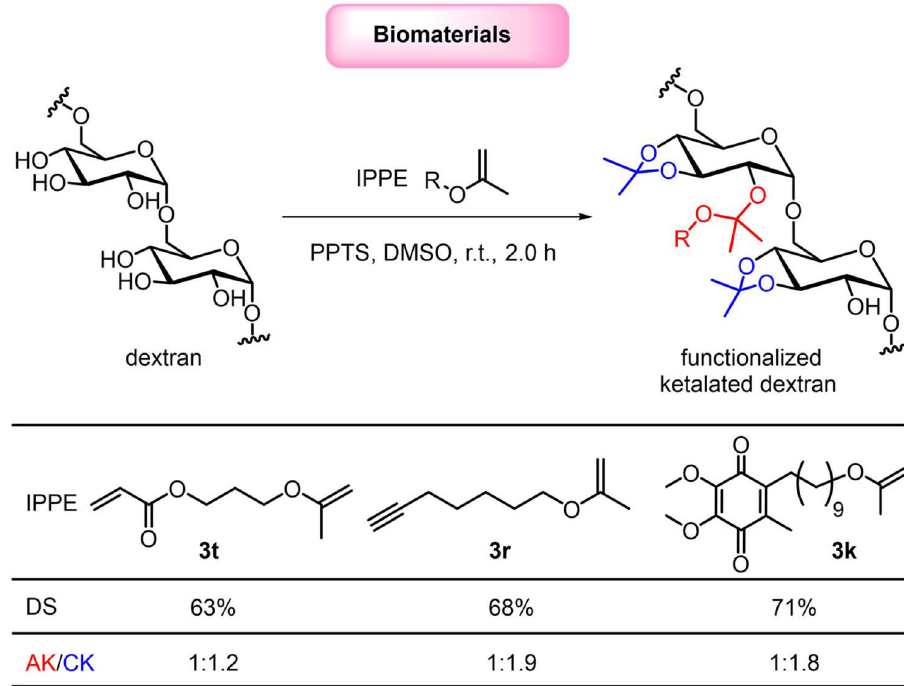
Fig. 6 Ketal-linked biomaterials. Synthesis of functionalized ketalated dextran, using addition reaction of IPPEs to hydroxyls of dextran under catalysis by pyridinium p -toluenesulfonate (PPTS). DS denotes the hydroxyl substitution degree; AK denotes the acyclic ketals; CK denotes the cyclic